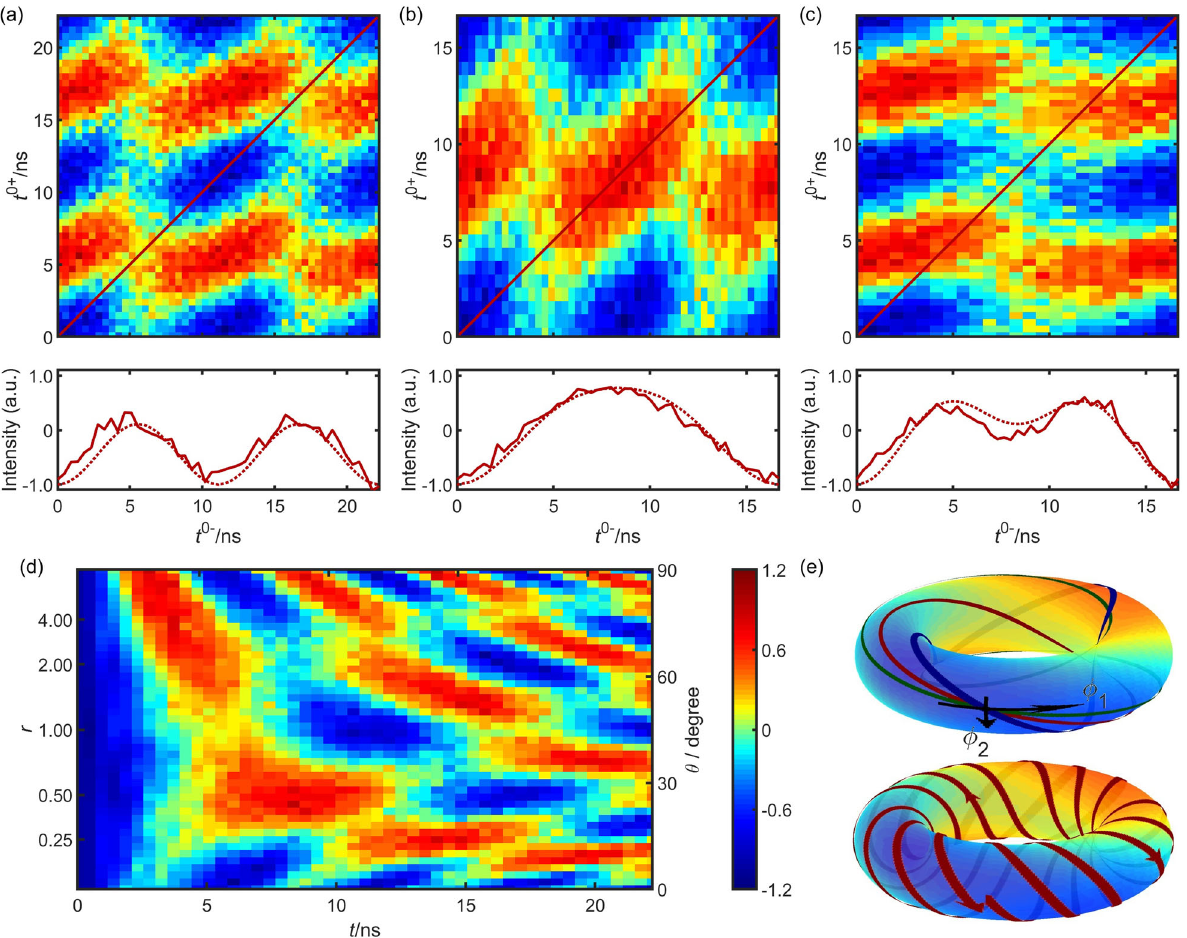
j i converted to 2